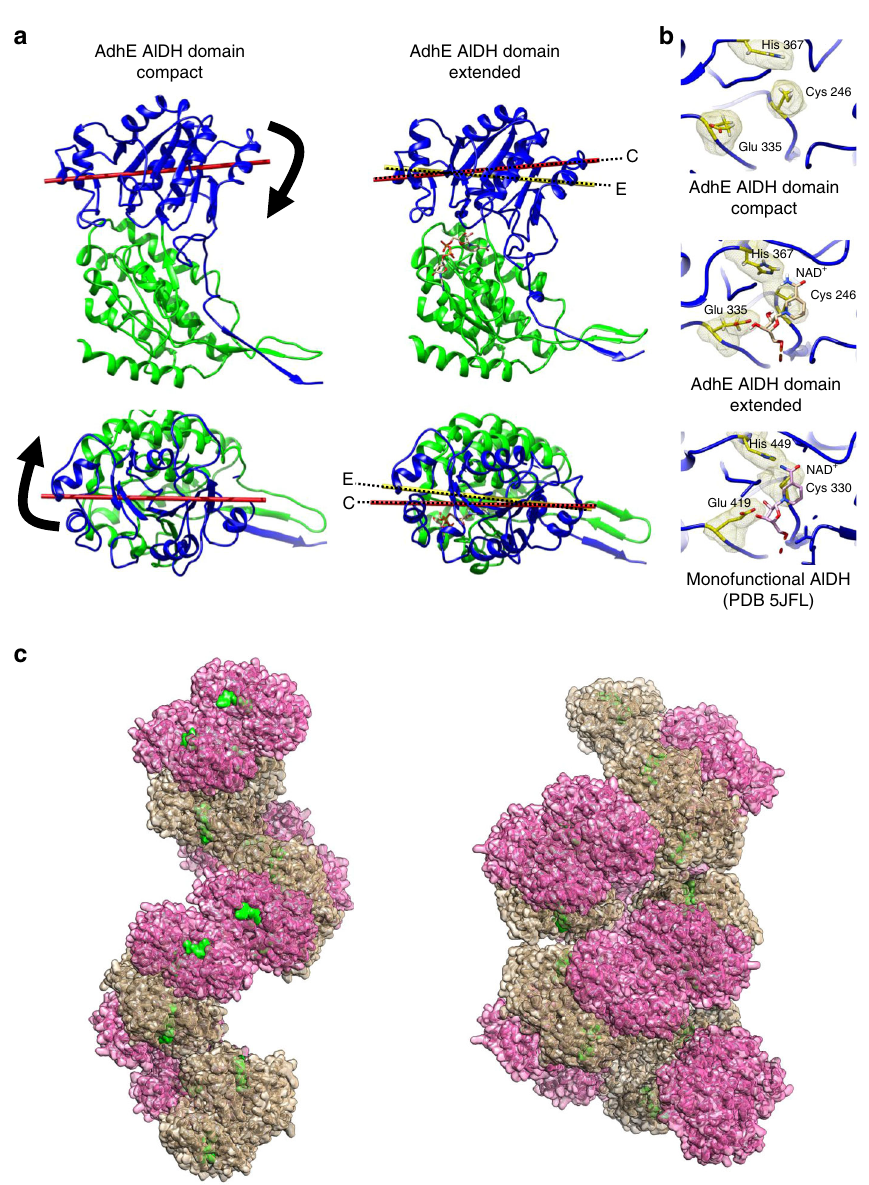
Fig. 5 Conformational changes between the AdhE compact and extended states. a Sub-domain motion in the AlDH domain. Ribbon representation of the AlDH domain from AdhE. The NAD-binding domain (residues 1 – 214) is colored in green. The catalytic domain (residues 215 – 448) is represented in blue. The NAD-binding domains are represented in the same position for the compact and extended state. The catalytic domain moves relative to the NAD- binding domain between AdhE compact and extended states. The axis of the catalytic domain is represented in red for the compact conformation (C) and yellow for the extended conformation (E). Top, side view of the AlDH domain. Bottom, view from the catalytic domain. b Zoomed view of the AlDH catalytic site of compact and extended AdhE and monofunctional propionaldehyde dehydrogenase from R. palustris . The proteins are represented as blue ribbons. The catalytic histidine, glutamate and cysteine are represented as sticks and volumes. They are colored in yellow. The NAD + molecules are represented as sticks. c Surface representation of the AdhE fi lament in its extended (left) and compact (right) conformation. The ADH domains are colored in beige and the AlDH domains are colored in pink. The NAD + molecules are colored in